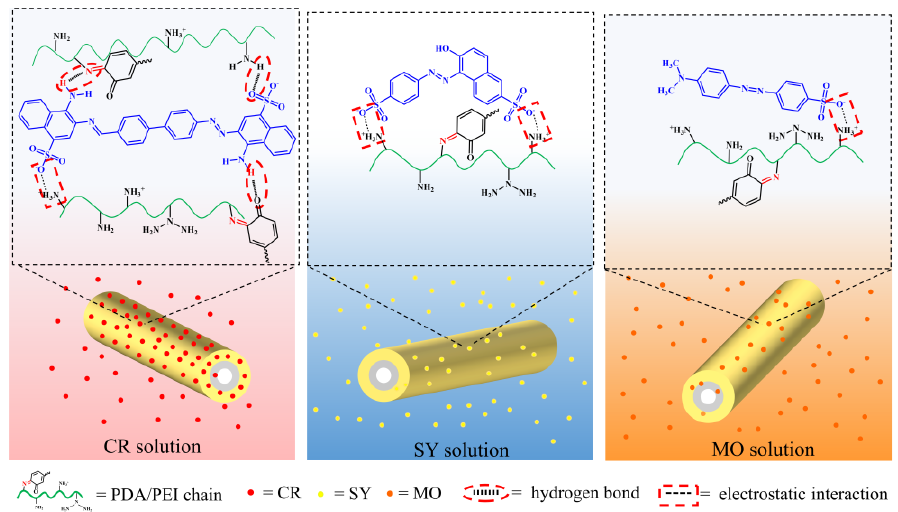
Figure 9. FTIR spectra of procured CR and PDA/PEI-TPU NFMs before and after adsorbed CR molecules .